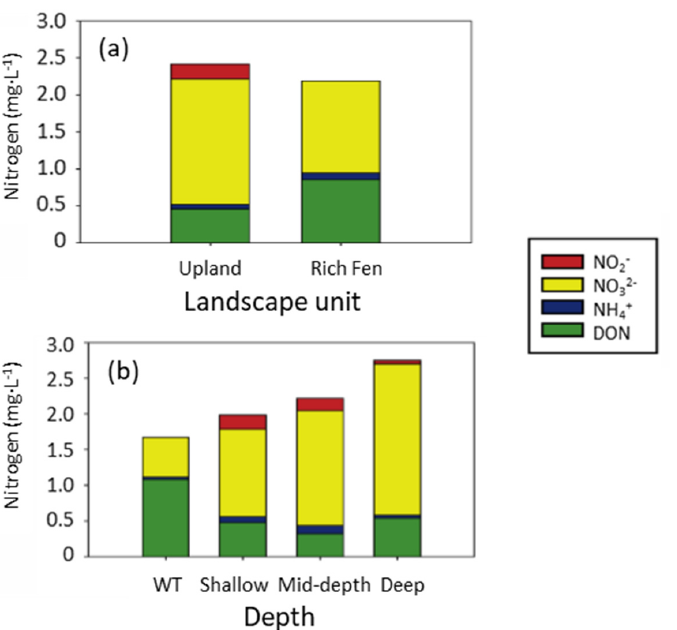
Figure 8. Summary of average nitrogen concentrations observed at JPH by ( a ) landscape unit and ( b ) depth (modified after [25]).